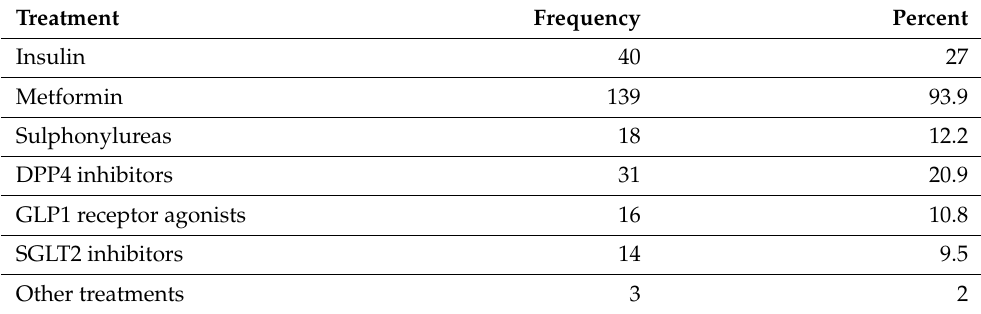
Table 2. Frequency of using different treatments for diabetes in the study population.